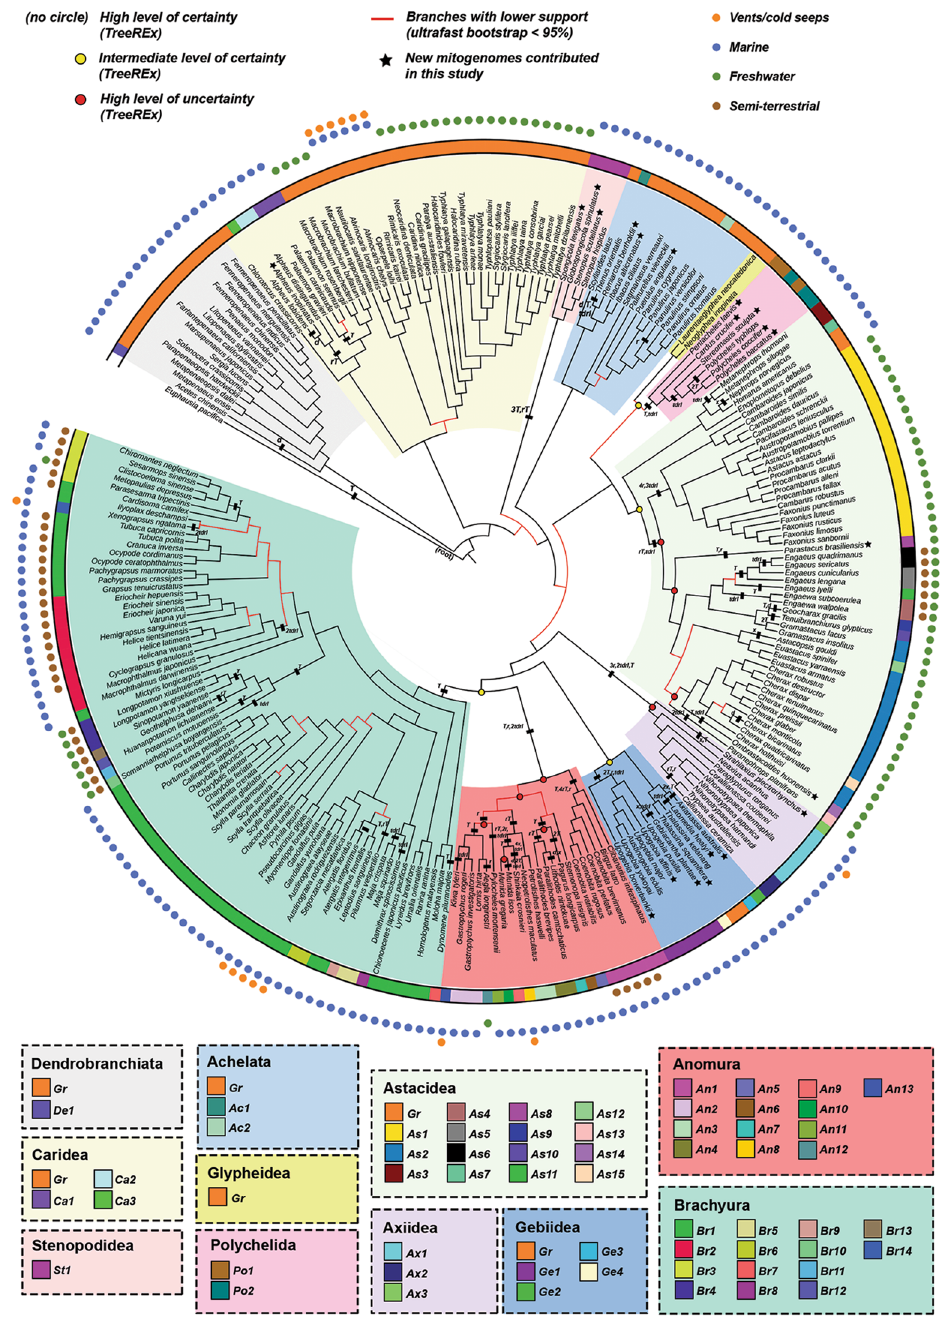
Figure 2. Decapod phylogenetic tree. This cladogram was inferred using the maximum-likelihood method based on Dataset I (13 mitochondrial PCGs, 10 359 nucleotide alignment). Clades are coloured according to the different infraorders. The outer colour strip in the phylogenetic tree represents the distribution of mitochondrial gene orders (MGO) in various infraorders and summarises a total of 59 different MGOs across the 246 different decapod species analysed, labelled for each infraorder in the panels below. Orange-coloured MGO labelled with ‘ Gr ’ refers to the pancrustacean ground pattern; other derived MGOs are numerically labelled and attached with a 2-letter infraorder prefix. MGOs that differ from the ground pattern are a result of a series of CREx-predicted gene rearrangement events: transposition ( T ), reversal ( r ), reverse transposition ( rT ), duplication ( d ), deletion ( x ) and tandem duplication-random loss ( tdrl ). Yellow- or red-coloured circles on some nodes reflect the level of uncertainty for the TreeREx reconstruction of each ancestral MGO, with red exhibiting highest level of uncertainty, yellow for mid-level and no circle for consistent reconstruction (see Babbucci, et al . 42 for details). Subsequent outer rings indicate, to the best of our knowledge, the possible environments (terrestrial, freshwater, marine, vents/seeps) inhabited by each decapod